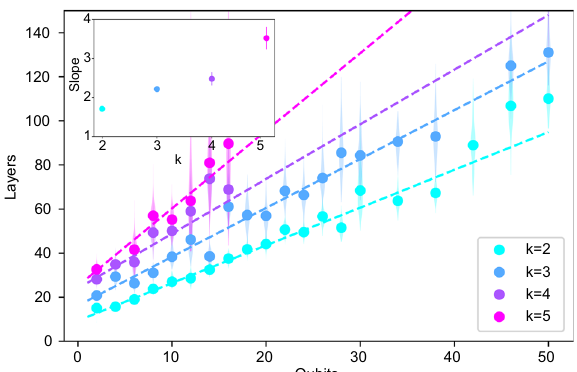
Fig. 9 Layer scaling as a function of the number of qubits for the hardware-ef fi cient ansätz. Missing data points are due to insuf fi - cient data (see Supplementary Discussions 3.1 for more details). The inset shows the fi tted slopes for different k values. Error bars show one standard deviation.